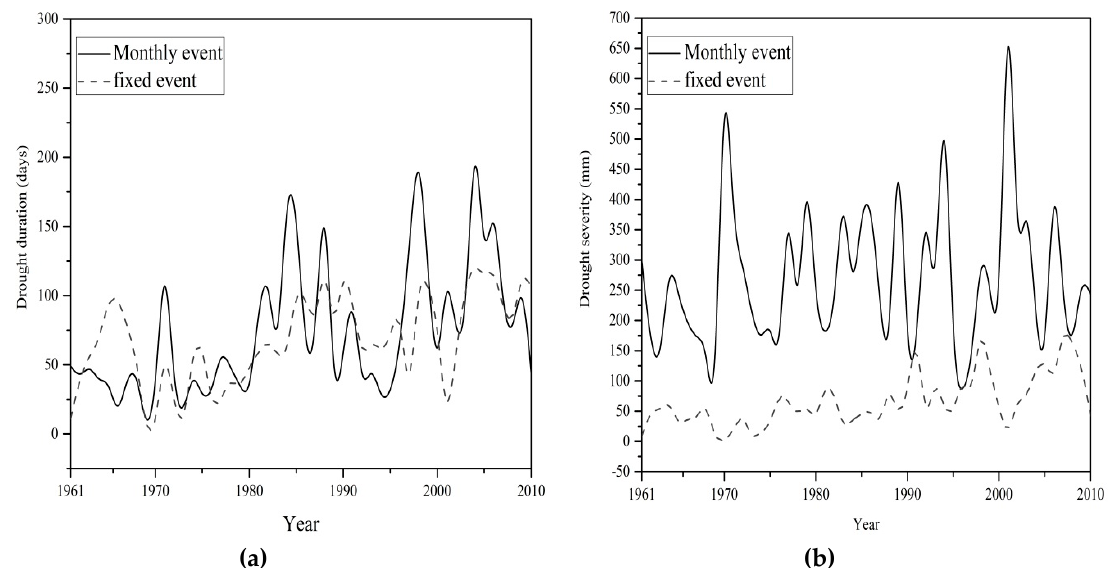
Figure 22. Annual number of drought events in Zone II.